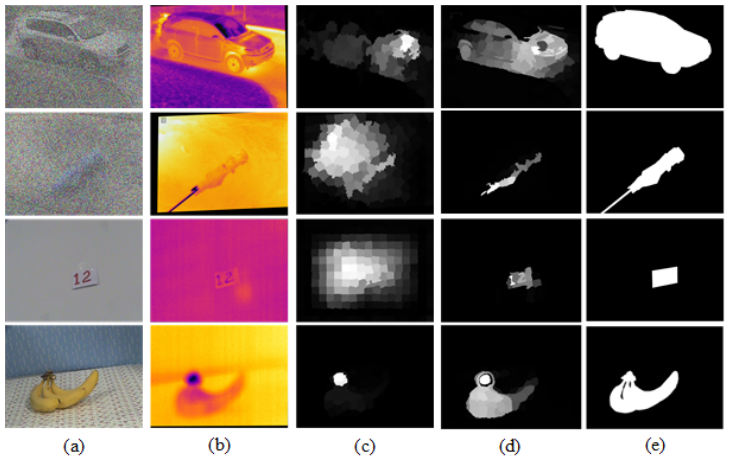
Figure 1. Comparative results of static-adaptive graph-based method with traditional static graph model. ( a ) RGB image; ( b ) thermal image; ( c ) the saliency map generated by the static graph-based model; ( d ) the saliency map generated by our model; ( e ) ground